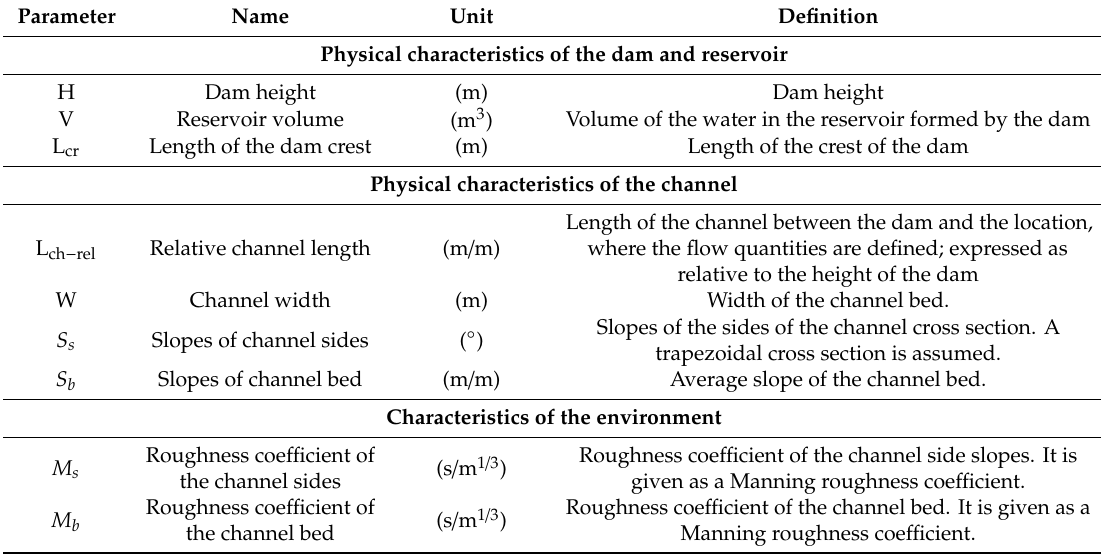
Table 1. Input parameters for the model of the flood wave propagation resulting from a concrete dam